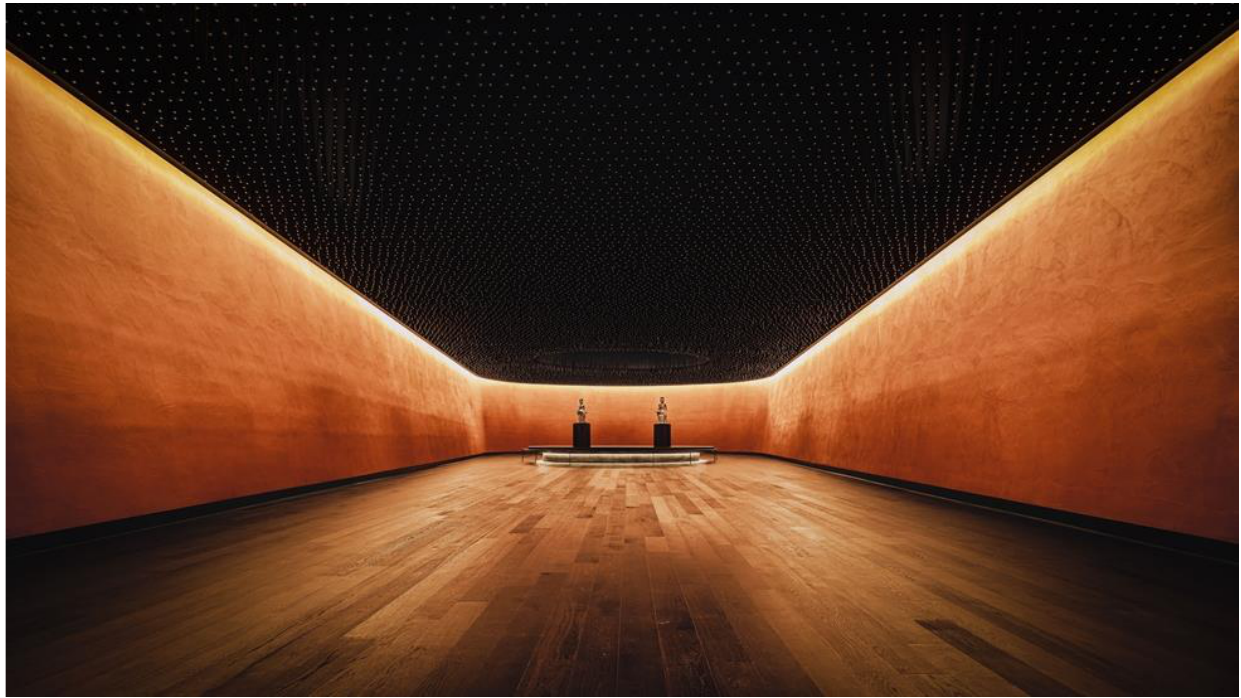
Figure 8. Vestibule leading to the entrance to “A Room of Quiet Contemplation”. Photos from The Korean JoongAng Daily, 1 February 2022. Photos in public domain.